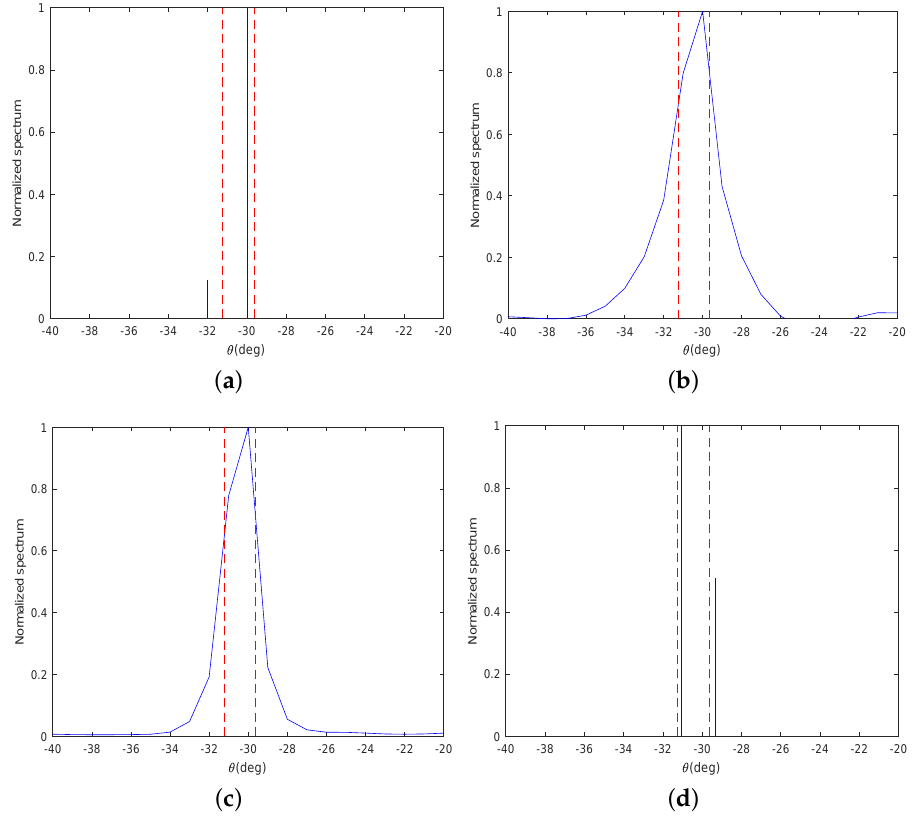
Figure 3. Resolution ability comparision for proposed method and other three algorithms with two closely spaced sources. ( a ) OGSBI; ( b ) LRD; ( c ) LASSO; ( d ) Proposed